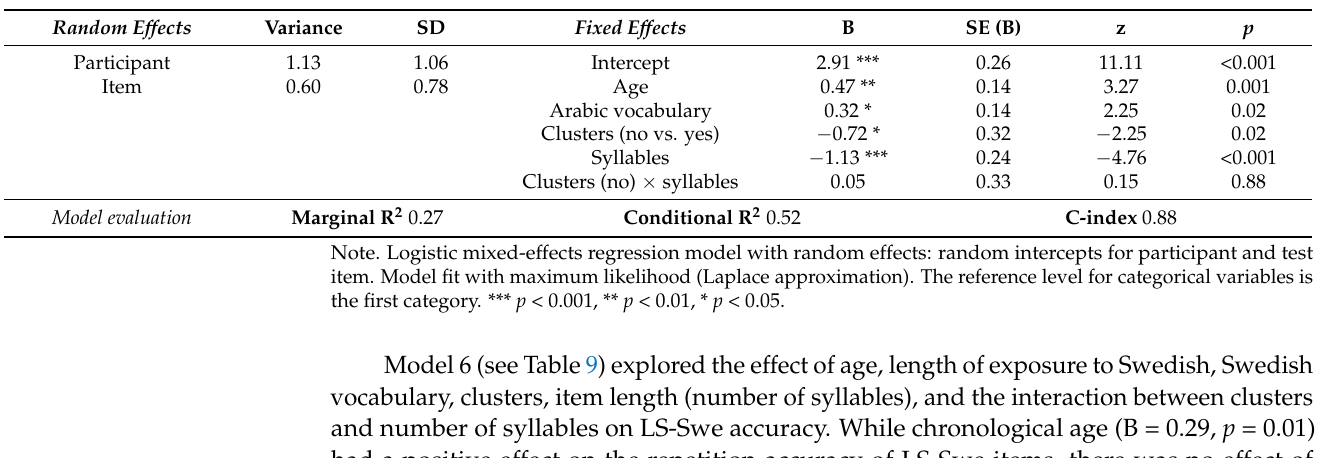
and presence of consonant clusters.